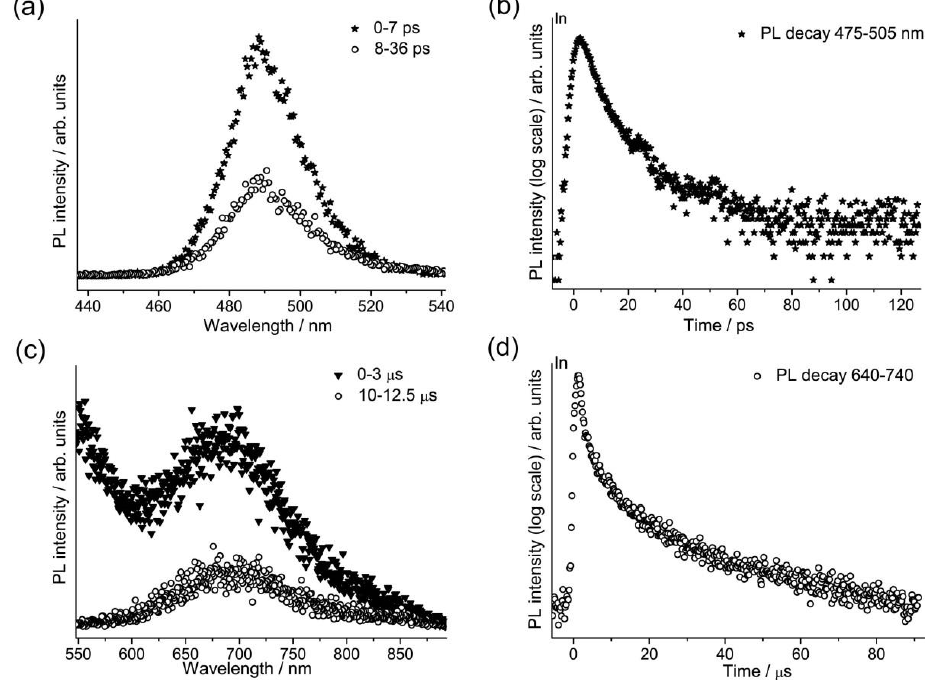
Figure 6. TRPL analysis of a yellow ((Zn,Cd)S) sample: gated PL spectra ( a ) in the 0–7